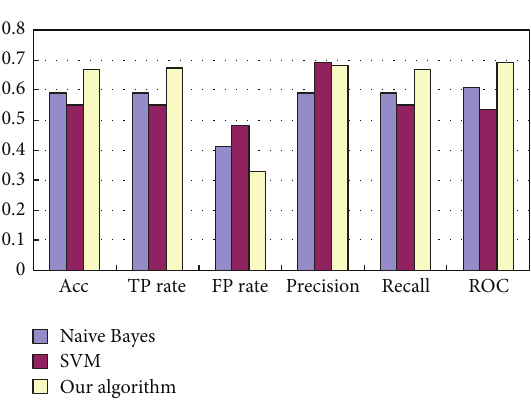
algorithmSVM Our